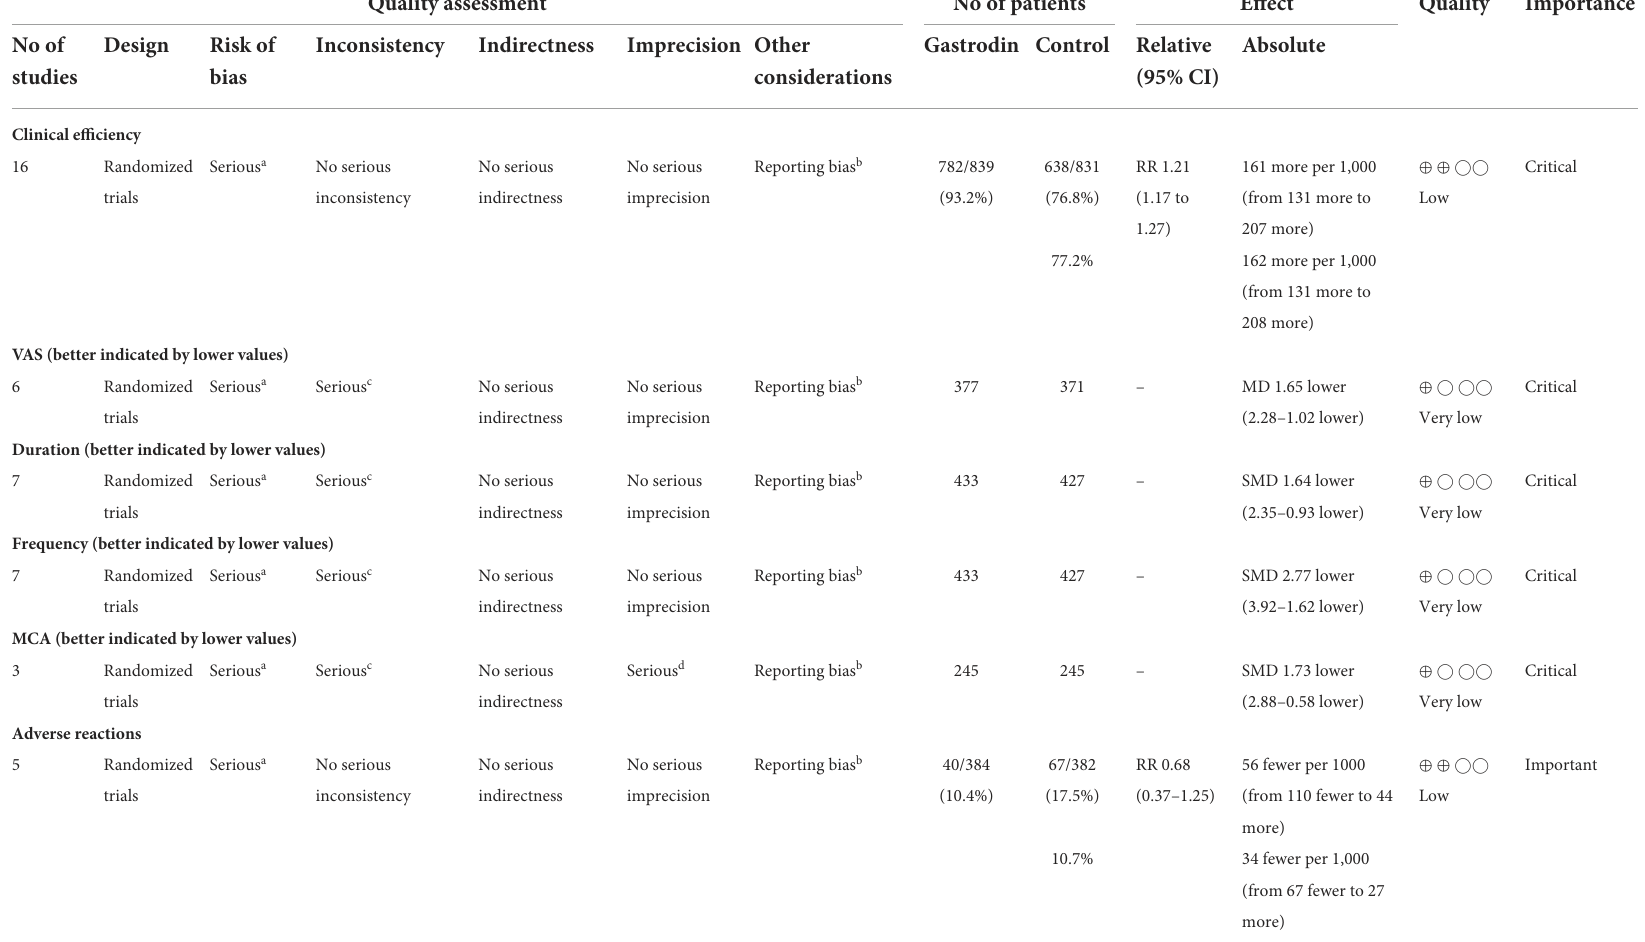
TABLE 3 Quality